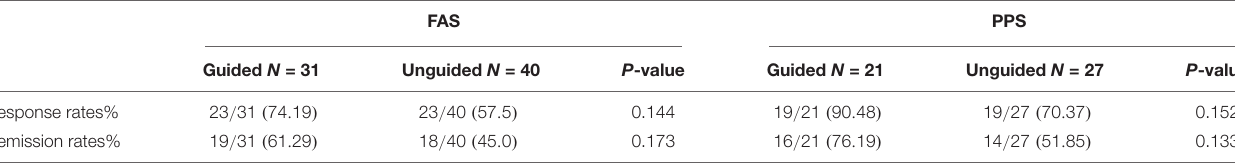
The p-values were obtained by the chi-square test.